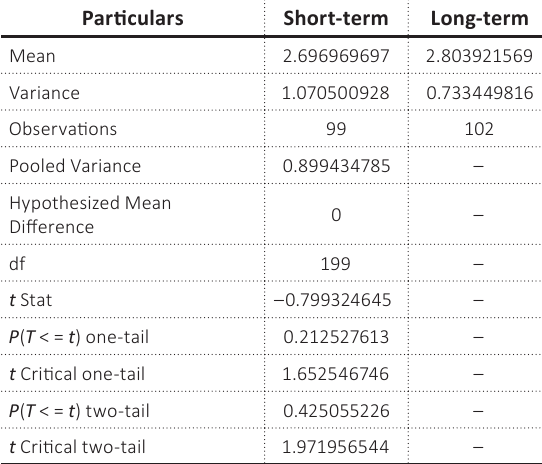
Table 9. t -test: Two-sample assuming equal